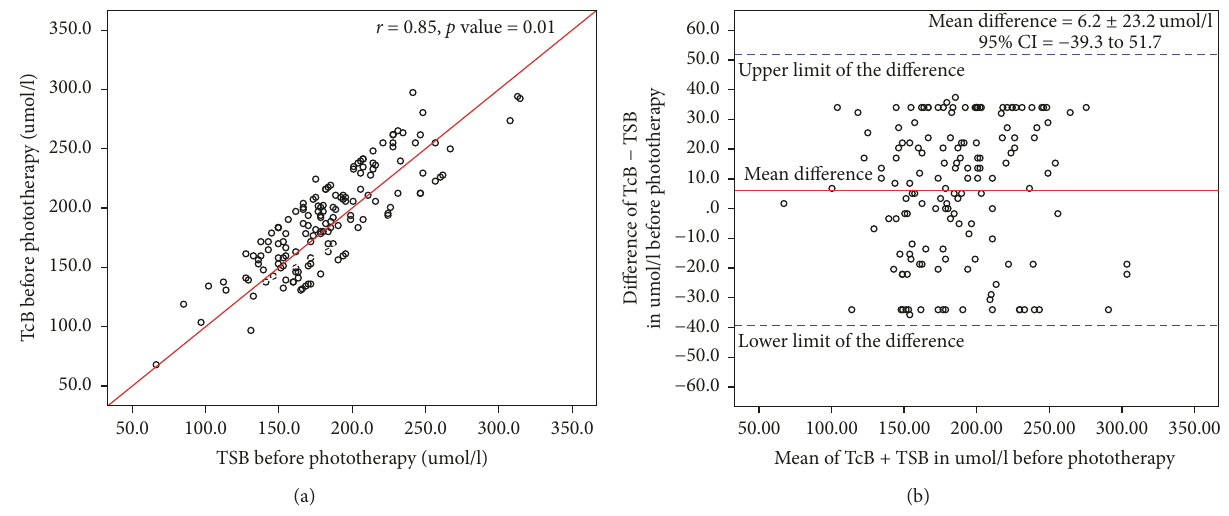
Figure 1: (a) Relationship between transcutaneous bilirubin (TcB) and total serum bilirubin (TSB) levels before starting phototherapy. (b) Bland-Atman Plot of transcutaneous bilirubin and total serum bilirubin values before starting phototherapy.